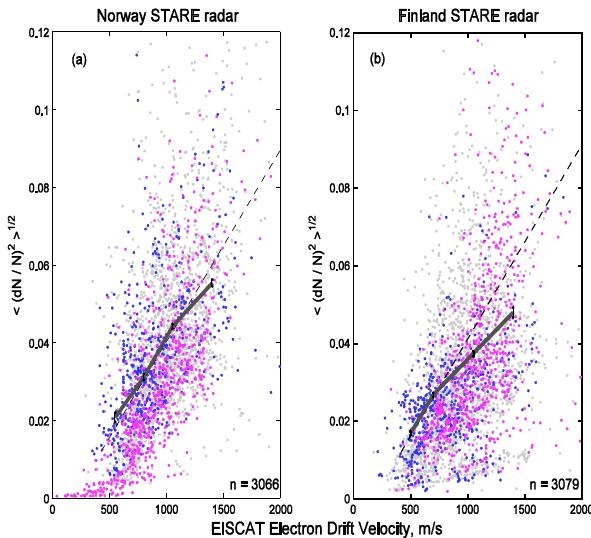
Fig. 6. Dependence of the RMS fractional electron density fluctua- D E 1 / 2 (δN/N) 2 tion amplitude (EDFA), , (inferred from (a) Norway and (b) Finland data) upon the mean electron drift velocity, V E × B . All measured EDFAs (blue, grey and pink dots) were grouped and averaged over four bins of the electron drift velocity centred at 500, 700, 1000 and 1400ms − 1 . Dashed lines are eye-adjusted lines co- locating with the low-velocity parts of the EDFA curves. Blue, pink and grey dots correspond to the low/high/middle effective electron density of ≤ 0 . 4 × 10 11 m − 3 , ≥ 1 . 0 × 10 11 m − 3 and within the in- terval of ( 0 . 4 − 1 . 0 ) × 10 11 m − 3 ,